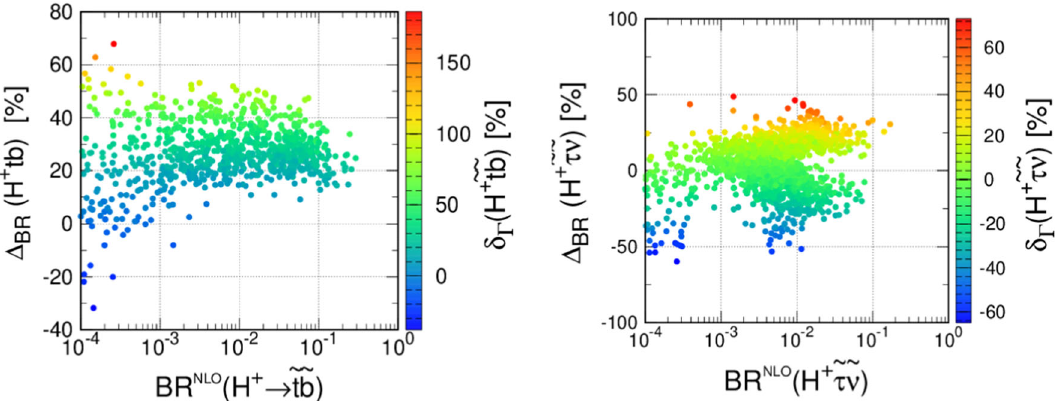
Fig. 6 Relative change in the branching ratio as defined in Eq. (135) for the H + decays into stop-sbottom (left) and stau-sneutrino (right) as a function of their NLO corrected branching ratio for all scan parame-